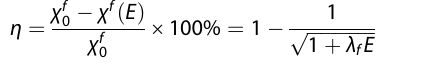
where a 1 ; a 11 ; a 12 ; a 111 ; a 112 and a 123 are the fi rst and high-order Landau coef fi cients determined under the stress-free condition. P i